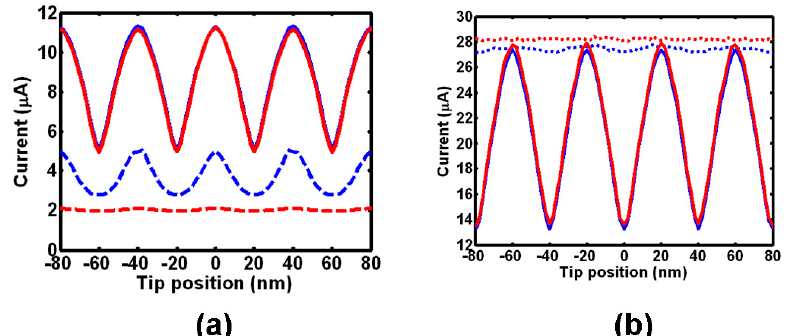
Figure 17. The resulting readout current for ( a ) multiple crystalline bit arrays, and ( b ) multiple amorphous bit arrays. The blue line and red line represent the readout signals for 40 nm track pitch and 60 nm track pitch respectively, while the solid line and dotted line indicate the ‘on-track’ scanning and ‘off-track’ scanning respectively.